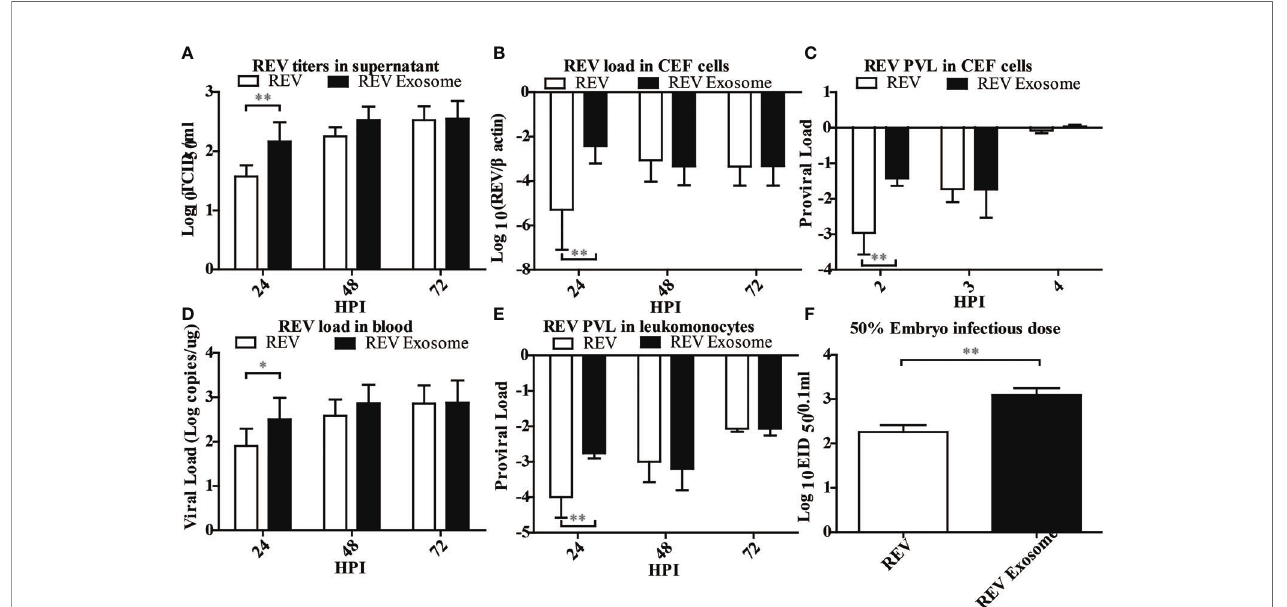
FIGURE 4 | Infection ability analysis of the REV exosome and free REV both in vivo and in vitro . (A) REV titers in supernatant of CEF cells treated with free REV and REV exosomes (10 6 genomic equivalents) at 24, 48, and 72 hpi, and the viral titers harvested at different intervals were calculated and expressed as TCID 50 per milliliter. (B) REV load in CEF cells treated with free REV and REV exosomes (10 6 genomic equivalents) at 24, 48, and 72 hpi, and REV viral load levels were normalized to b -actin. (C) REV proviral load in CEF cells treated with free REV and REV exosomes (10 6 genomic equivalents) at 2, 3, and 4 hpi, and REV proviral load levels were normalized to HMG14b . (D) REV viral load in the blood of SPF chicks treated with free REV and REV exosomes (10 6 genomic equivalents) at 24, 48, and 72 hpi, and viral RNA concentration (log10) were normalized per 1 µg of total RNA. (E) REV proviral load at 24, 48, and 72 hpi were determined by the presence of REV-cDNA in the leukomonocytes of SPF chicks treated with free REV and REV exosomes (10 6 genomic equivalents), and REV proviral load levels were normalized to HMG14b . (F) The viral titers of free REV and REV exosomes (10 6 genomic equivalents) were determined with the EID 50 assay. *Indicates signi fi cant difference (p < 0.05) between the two experimental groups. **Indicates signi fi cant difference ( p < 0.01) between the two experimental